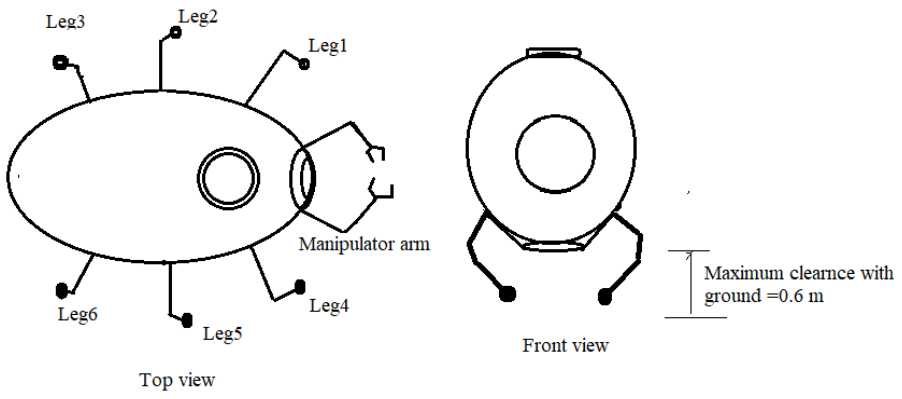
Table 5. Specifications of UMSWR links and joints.